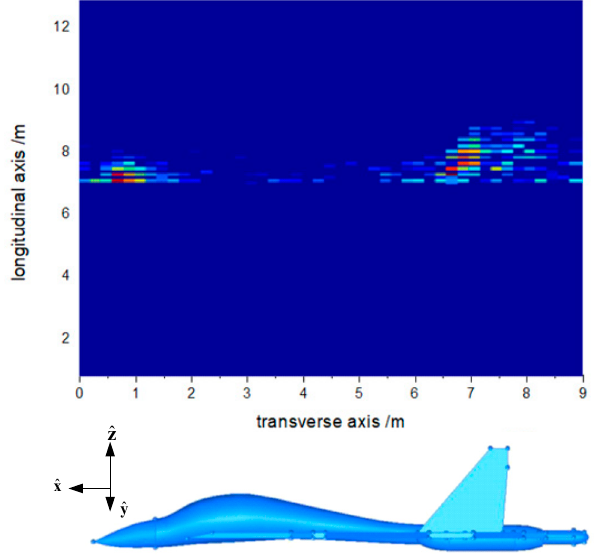
Figure 11. Aircraft model imaging by CS-MLFMA.